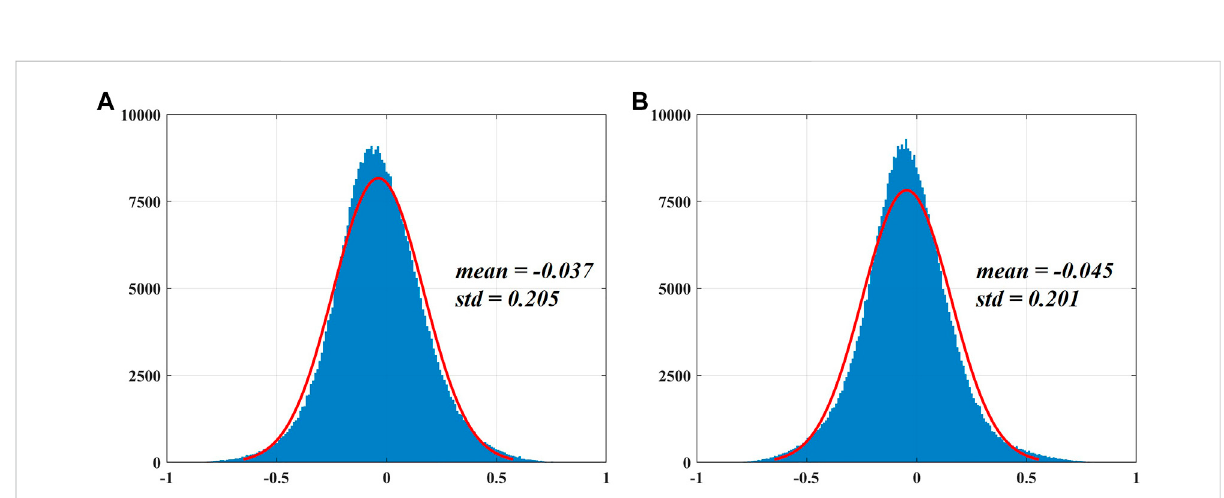
FIGURE 9 The error histogram of the study area (A) VV channel (B) VH channel.